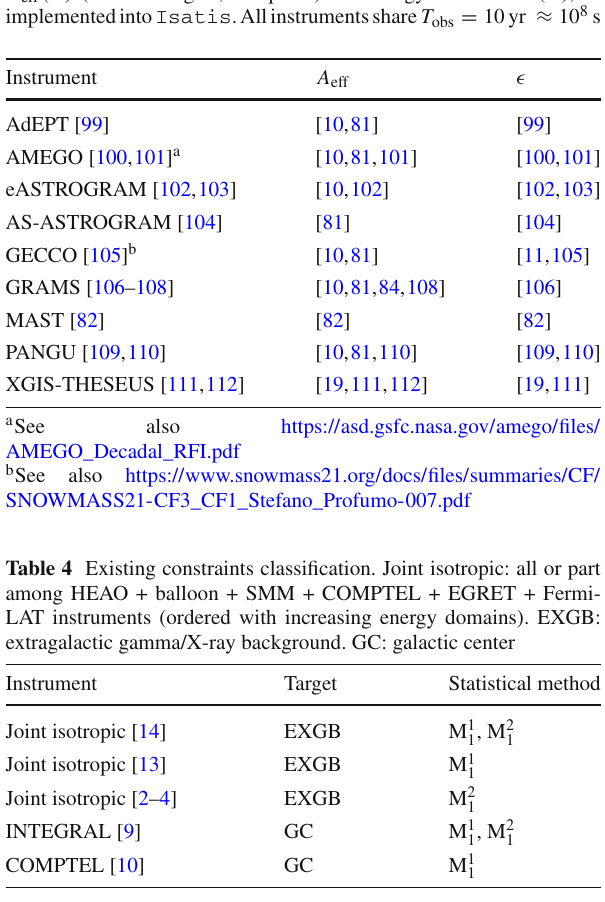
Table 3 Prospective optical instruments references for effective area A eff ( E ) (see also Fig. 4, left panel) and energy resolution (cid:14)( E ) , as